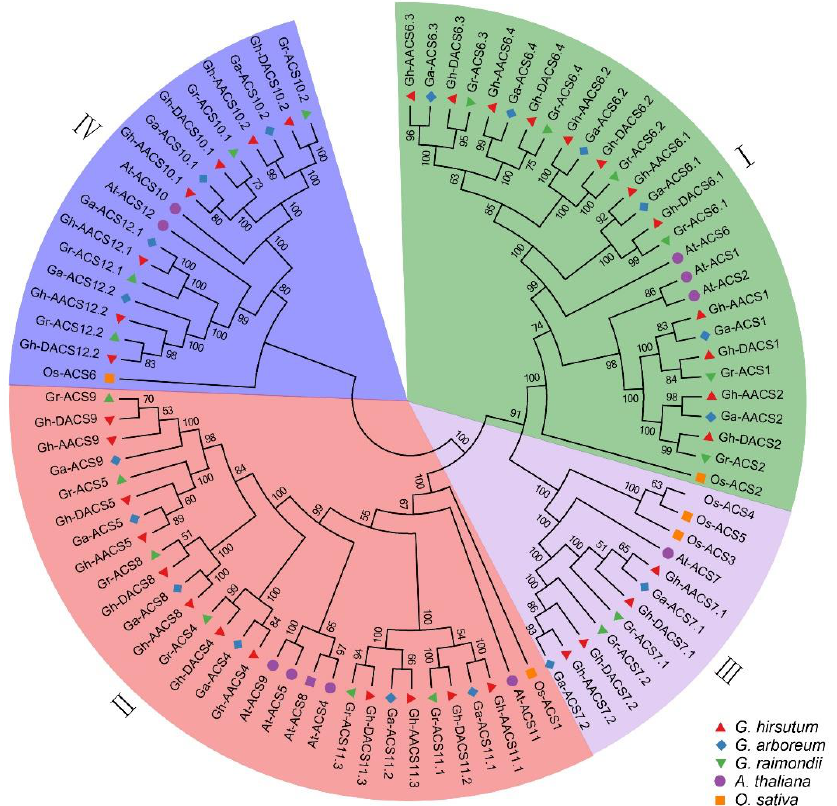
Figure 1. Phylogeny relationship of the ACS proteins in cotton and other species. The neighbor- joining phylogenetic tree was constructed based on a multiple sequences alignment of 88 ACS protein sequences from five species including G. hirsutum (GhACS), G. arboreum (GaACS), G. raimondii (GrACS), Oryza sativa (OsACS), and A. thaliana (AtACS), with 1000 bootstraps and model of p -distance, in which the ACS proteins family was divided into four subgroups. The different colored shapes: red triangle, blue diamond, green inverted triangle, purple circle, and orange square were used to indicate G. hirsutum , G. arboreum , G. raimondii, A. thaliana , and O. sativa ,